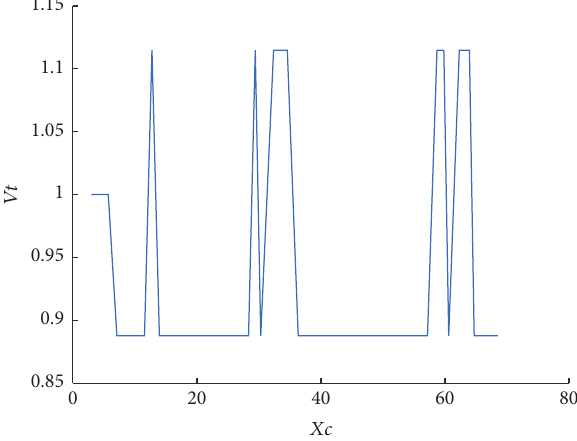
Figure 10: Three omnidirectional wheels’ velocity.